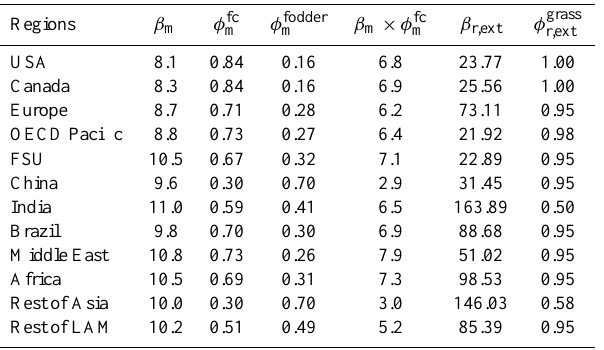
Table 4. Monogastric feed conversion factor β m (kcal of feed/kcal of monogastric product). Share of food crops φ fc m and fodder φ fodder m in feed. Calories of food crop needed to produce one calorie of monogastric meat and eggs β m × φ fc m . Feed conversion factor of ex- tensive ruminants β r,ext . Share of grass in feed φ grass r,ext . From Bouw- man et al. (2005) and modified as explained in Sect. 5.4